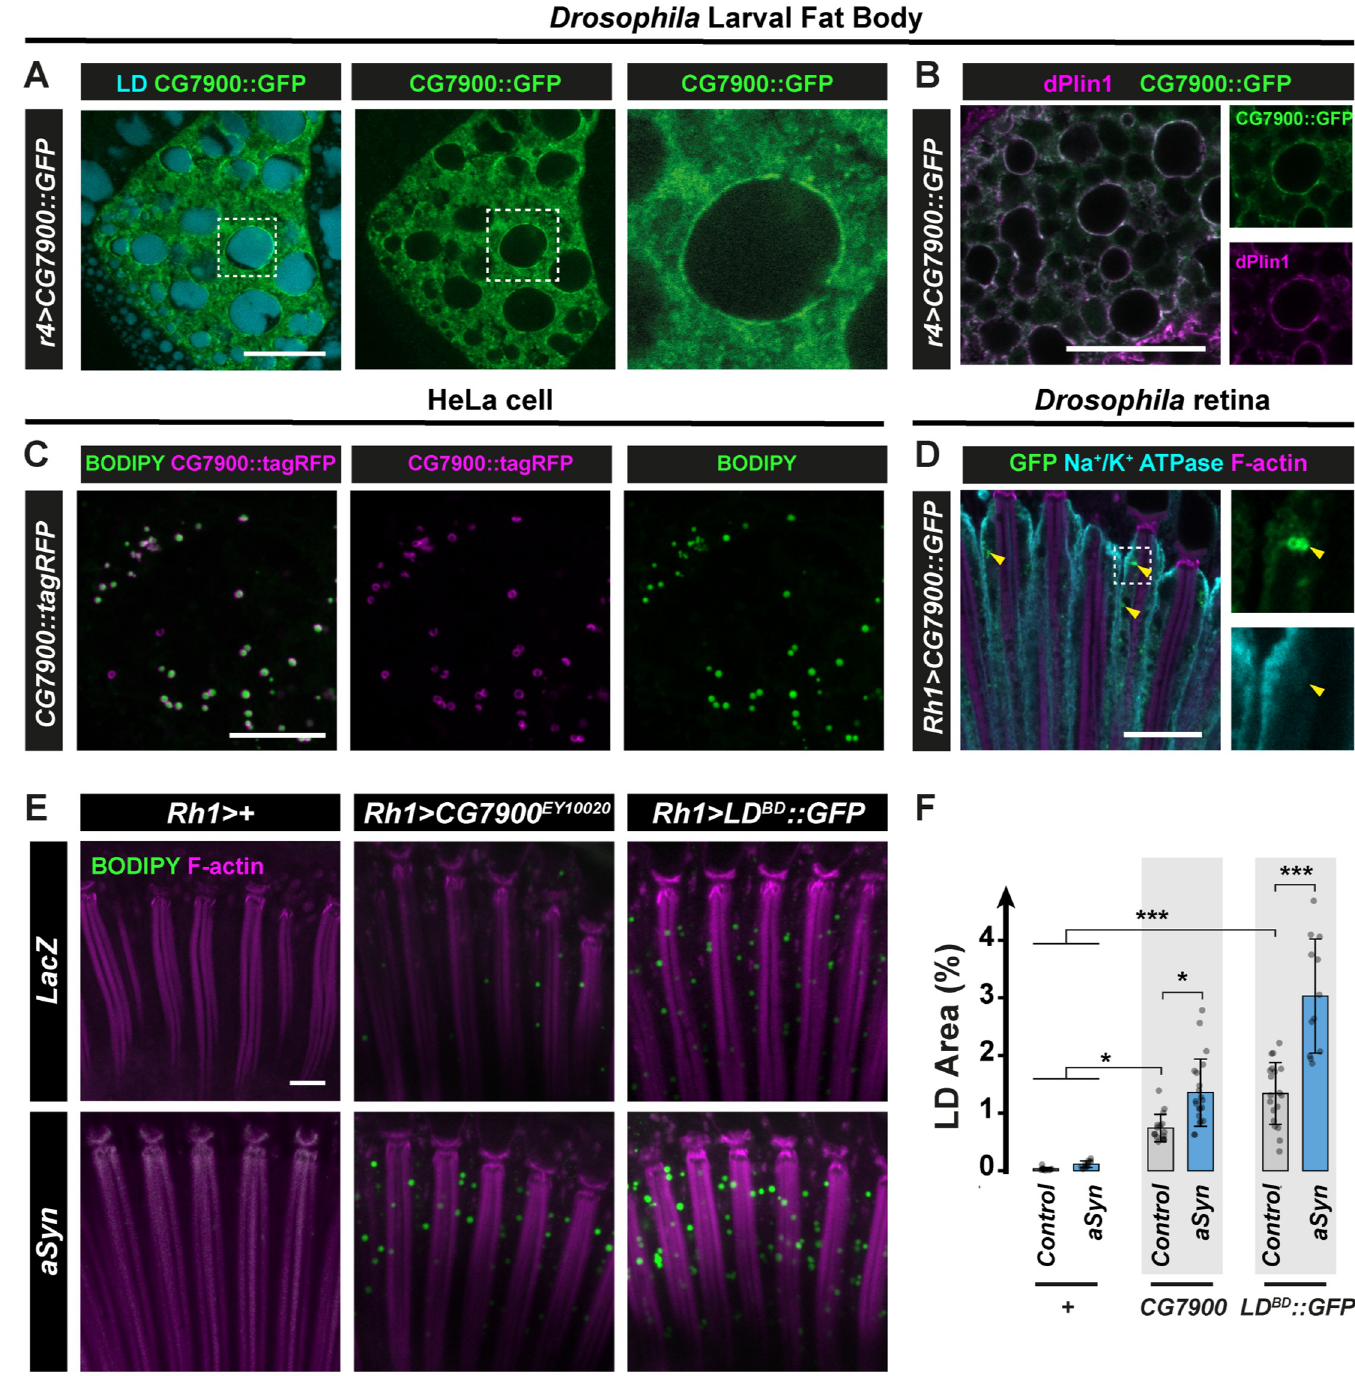
Fig 5. CG7900 binds LDs in Drosophila tissues and promotes LD accumulation in photoreceptors. (A) Immunostaining of whole mount Drosophila larval fat body expressing CG7900::GFP ( r4-GAL4 ). CG7900::GFP is in green and LDs, stained with AUTOdot, are in cyan. Scale bar, 20 μ m. (B) Immunostaining of whole mount Drosophila larval fat body expressing CG7900::GFP ( r4-GAL4 ). CG7900::GFP is in green and LDs are labeled with anti-dPlin1 (magenta). Scale bar, 20 μ m. (C) LD staining of HeLa cell transfected with CG7900 :: tagRFP . CG7900::tagRFP is in magenta and LDs are in green (BODIPY). Scale bar, 10 μ m. (D) Immunostaining of whole- mount retinas from flies expressing CG7900::GFP in photoreceptor neurons ( Rh1-GAL4 ). Photoreceptor plasma membranes are in cyan (anti-Na + /K + ATPase) and rhabdomeres are in magenta (phalloidin-rhodamine). Arrowheads indicate ring shaped GFP positive staining in photoreceptors. Scale bar, 10 μ m. (E) LD staining of whole-mount retina from flies with photoreceptor neuron-specific expression ( Rh1-GAL4 ) of LacZ (control), CG7900 EY10020 ( EP-[UAS] insertion, EY10020), Klarsicht LD-binding domain (LD BD ::GFP), alone or in conjunction with α Syn. LDs are shown in green (BODIPY) and photoreceptor rhabdomeres in magenta (phalloidin- rhodamine). Scale bar, 10 μ m. (F) Quantification of LD area from the images shown in (E). Mean ± SD. � p < 0.05, ��� p < 0.001 by ANOVA with Tukey’s HSD test.